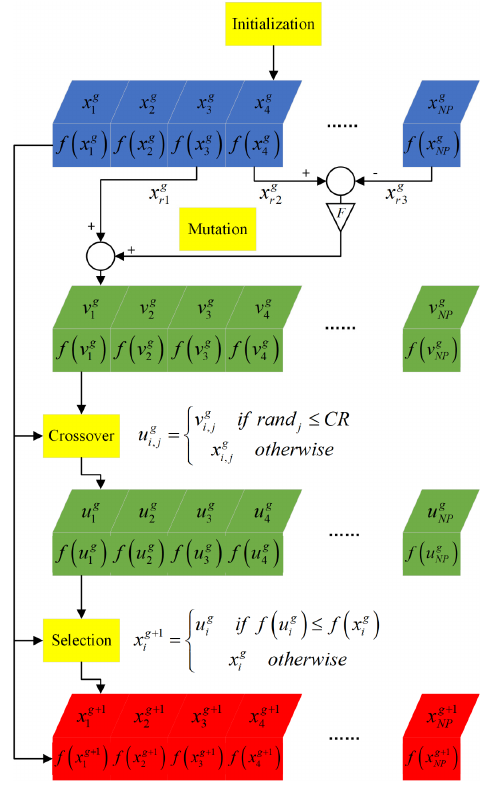
Figure 8. The flowchart of SDE.